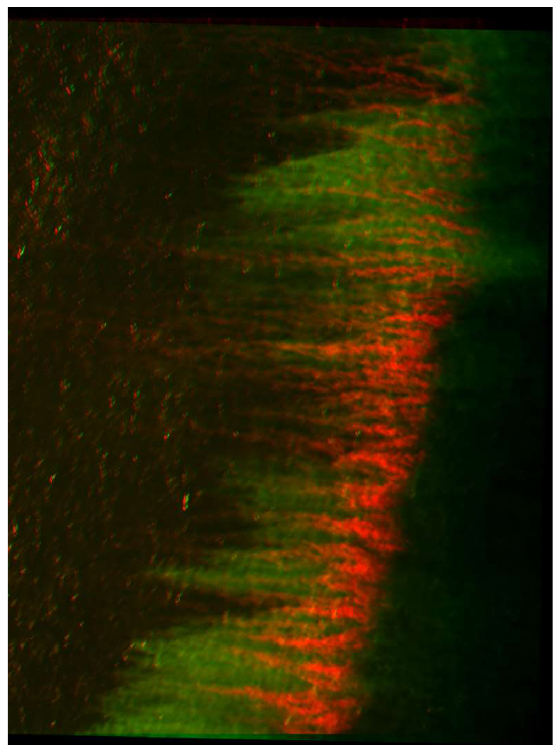
Figure 3. Overlapping Uranine and Rhodamine dye plumes obtained by two high-resolution monochrome cameras (ImperX) with green and red filters.